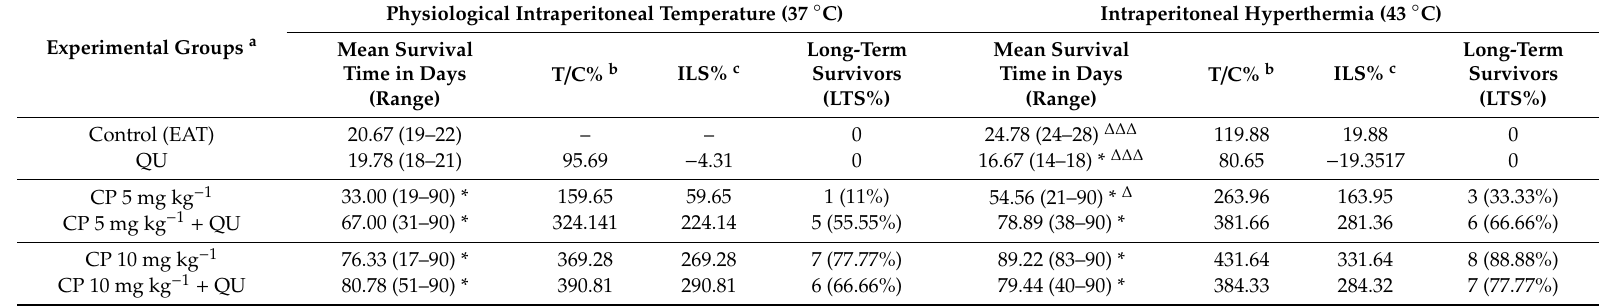
Table 3. Survival analysis of Swiss albino mice bearing Ehrlich ascites tumor after therapeutic treatment with cisplatin and QU under physiological and hyperthermic